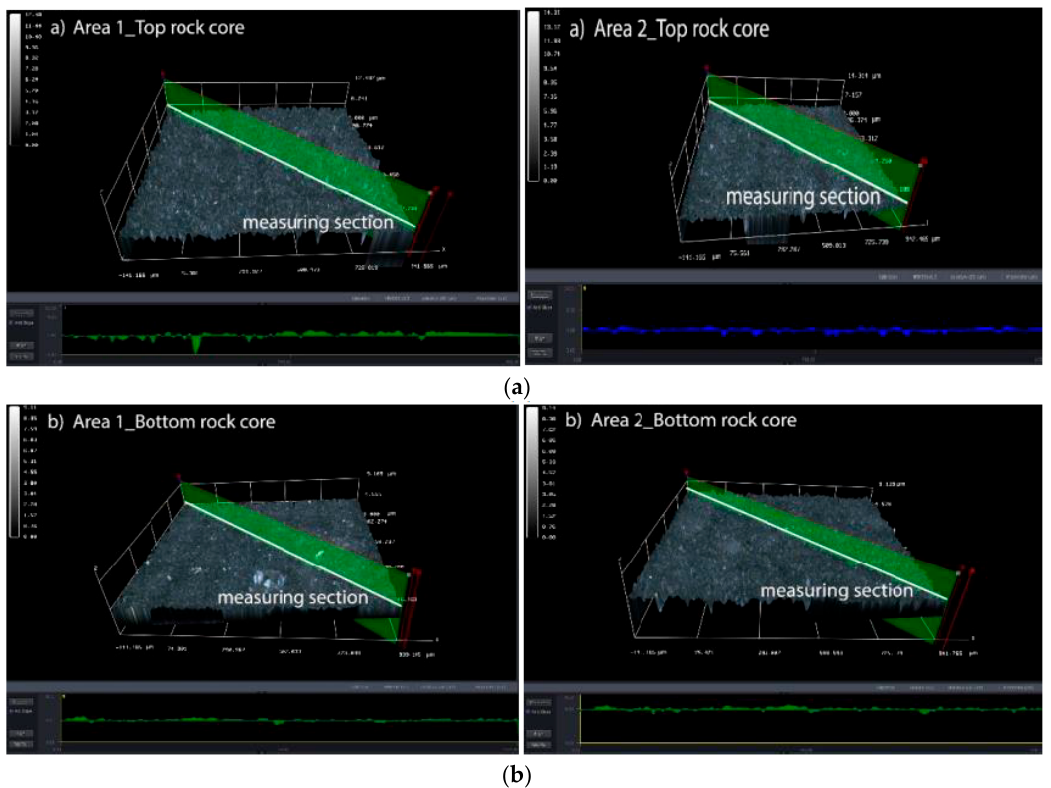
Figure 10. Determination of the primary roughness of the core plug face (fracture faces): ( a ) Top; ( b )